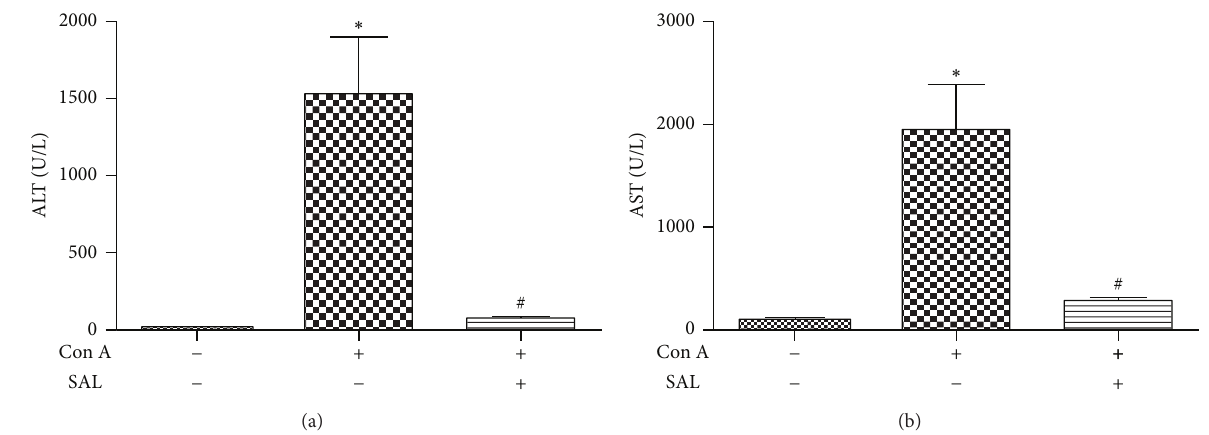
Figure 1: Salidroside pretreatment attenuated liver damage followed Con A administration. (a) and (b) demonstrated salidroside reduced ALT and AST levels in mice 12 h after Con A administration ( 𝑛 = 10 mice per group); ∗ 𝑃 < 0.01 versus control group, # 𝑃 < 0.01 versus Con A